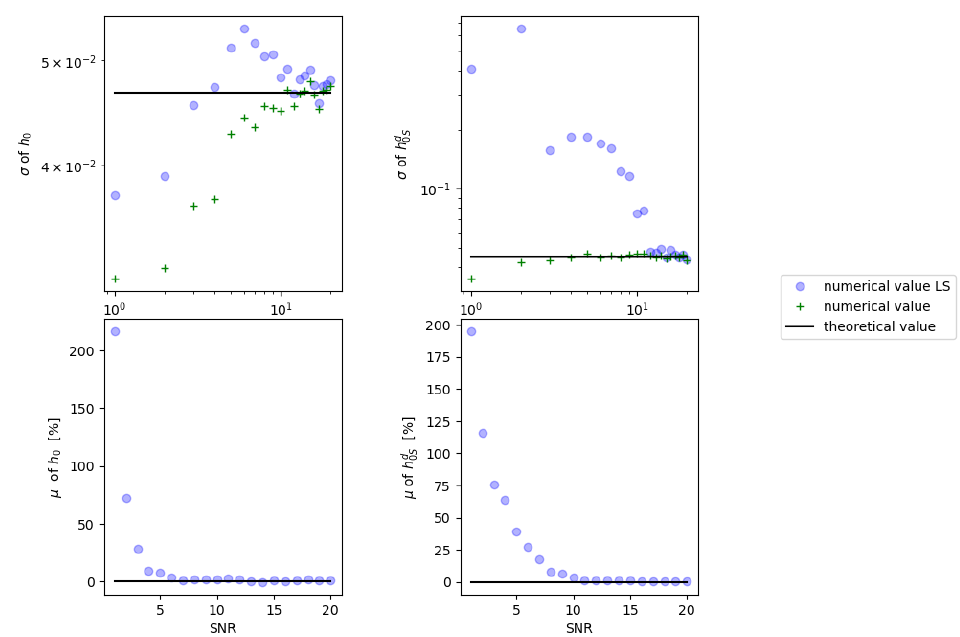
Figure 6. Bias and standard deviation of estimators of the two amplitude parameters h o ( left panels) and h d o ( right panels). The crosses are for initial estimators obtained from the Equations(136) and (139) and the dots are for the estimators from the least-squares procedure. Continuous lines are theoretical predictions from the Fisher matrix. The standard deviation is a log-log plot.